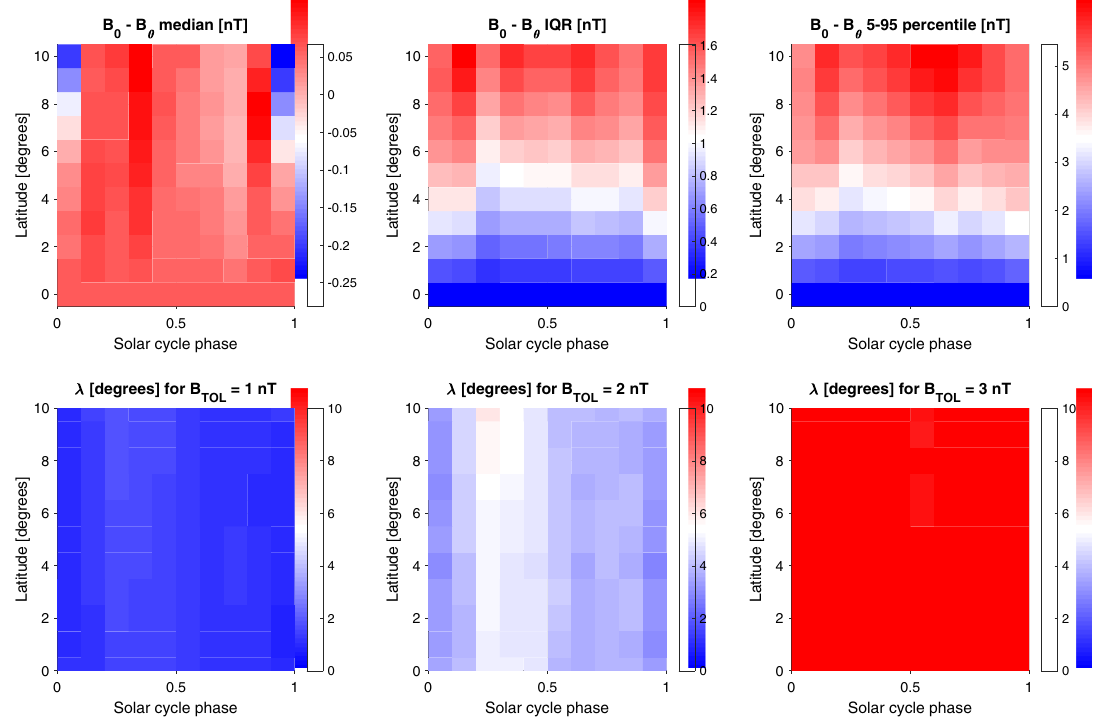
Fig. 9. Summary plots for the HMF intensity, B . Top: Figure 6, but for B . That is, the error introduced by assuming B at latitude h is representative of latitude 0, i.e. B 0 (cid:3) B h . Panels, from left to right show the median, interquartile range, and 5 – 95 percentile range of the distributions as a function of latitude and solar cycle phase. Bottom: Figure 8, but for B . That is, the localisation parameter, k , as a function of latitude and solar cycle for three B error tolerances of B TOL = 1, 2, and 3